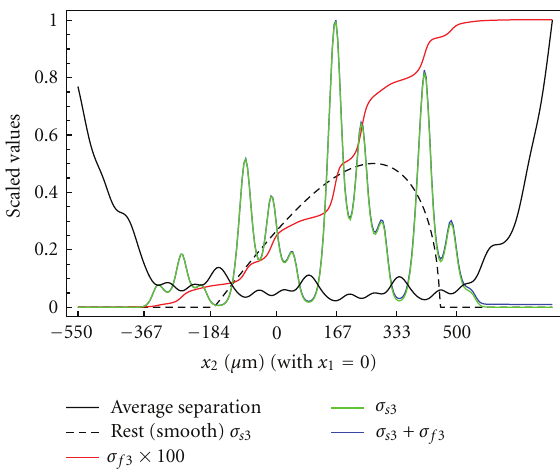
Figure 6: All solutions in arbitrary scaling.